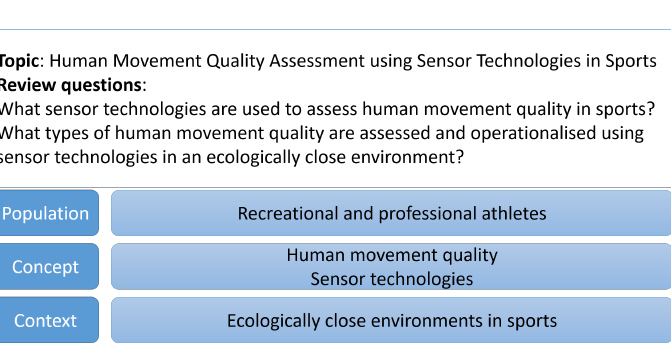
Figure 1. PCC framework of the current scoping